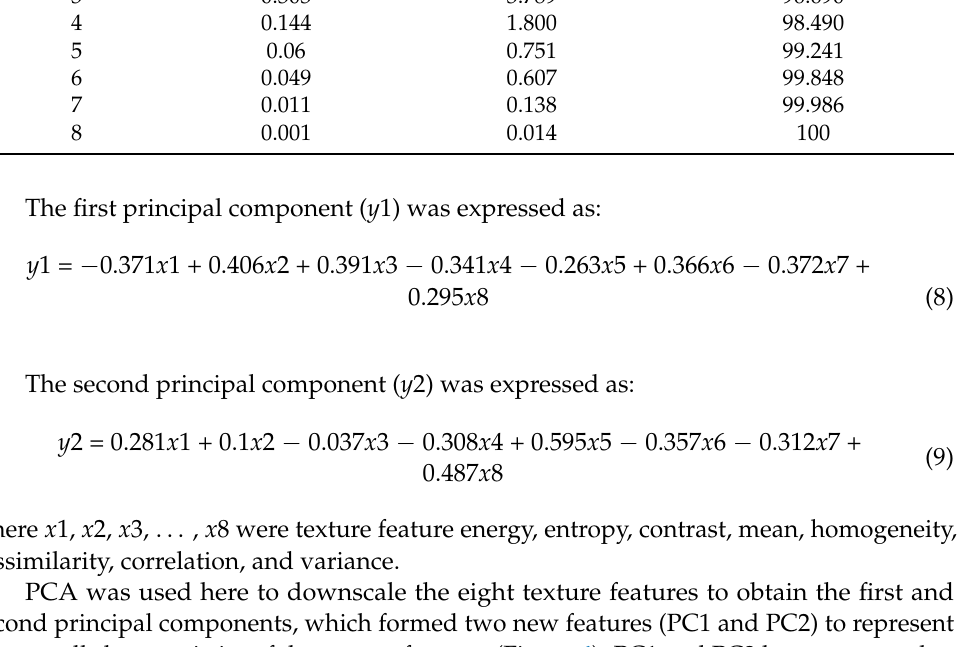
Table 3. Eigenvalues and contribution of principal components.